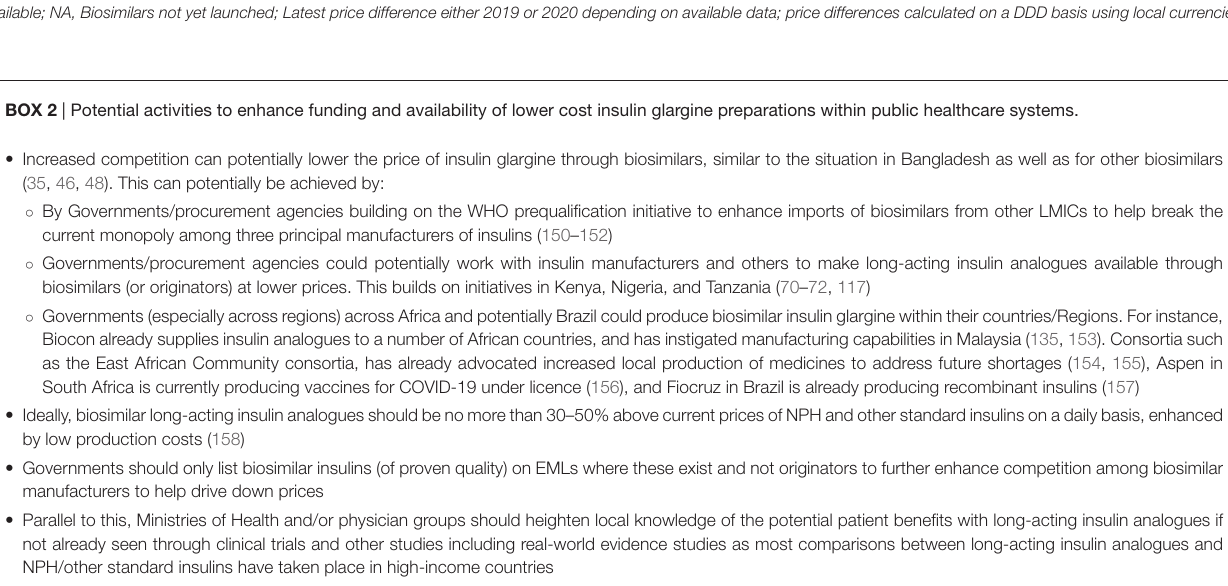
Price difference Latest price % Gla-300 originator over time difference (Bio vs. (%) Originator—%)